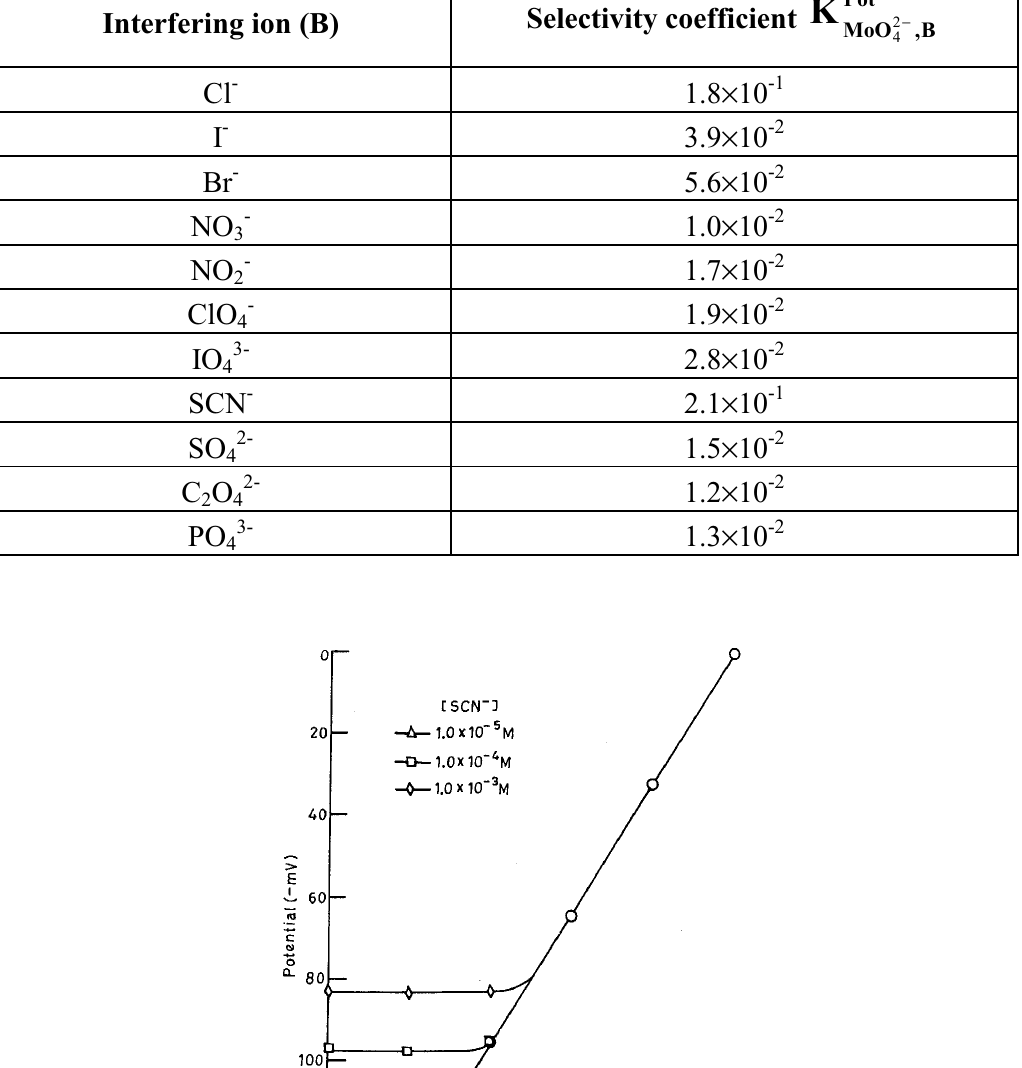
Table 4. Selectivity coefficient values sensor as obtained by using modified form of Fixed Interference Method.